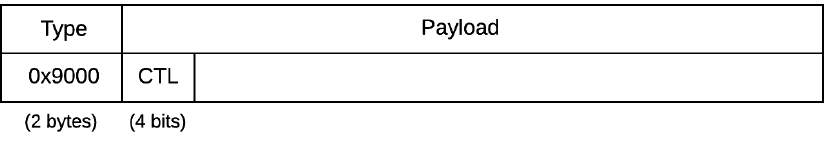
Figure 7. Sub-structure of a control